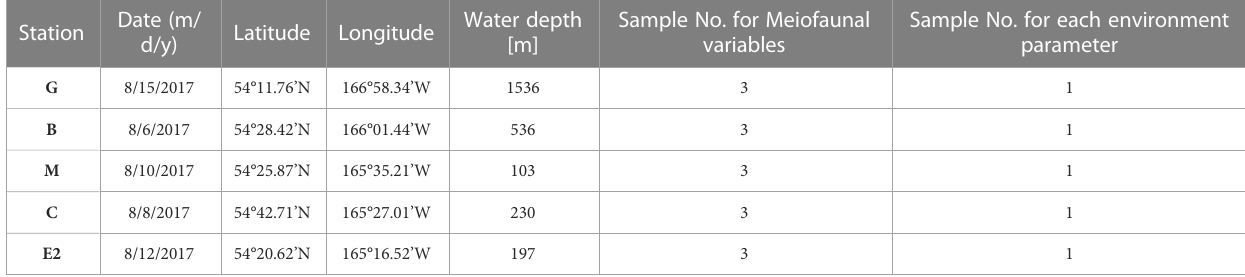
Tablelegend:Amulticorerwasdeployedtoobtainsedimentsamplesformeiofauna(3coresperstation),microbiological(1coreperstation)andsedimentanalyses(1coreperstation).Detailsof sampling dates, locations, depth, and number of sediment cores collected for this study are